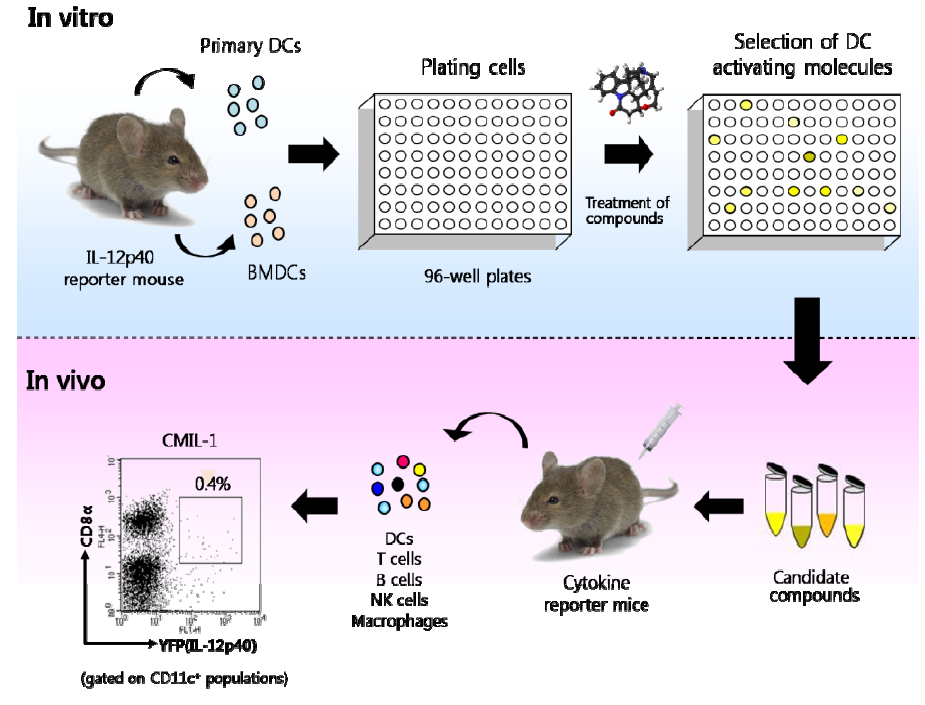
Figure 6. The protocol for screening and characterizing molecules with DC-stimulating activities. In brief, DCs from IL-12 p40 reporter mice are incubated with testing compounds and subsequently YFP-inducing compounds are selected by flow cytometry or fluorescence microscopy. Various cytokine reporter models can be used to examine the candidate compounds for their immunostimulatory effects in vivo. One FACS datum indicates that a subset of DCs can induce IL-12 p40 upon in vivo administration of CMIL-1 which is one of the compounds selected by this procedure (adapted from Ref [64] with permission from The Korean Society for Molecular and Cellular